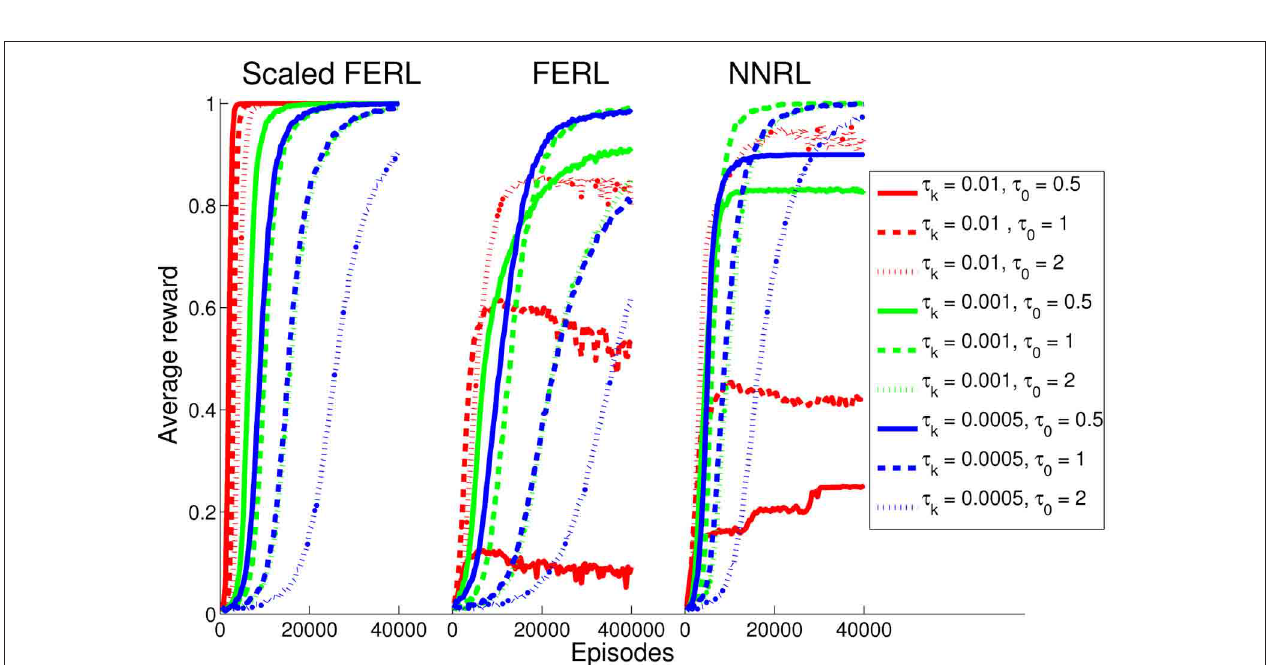
FIGURE 4 | The average reward computed over every 100 episodes and 20 simulation runs, for scaled FERL (left panel), FERL (middle panel), and NNRL (right panel). The line colors correspond to the